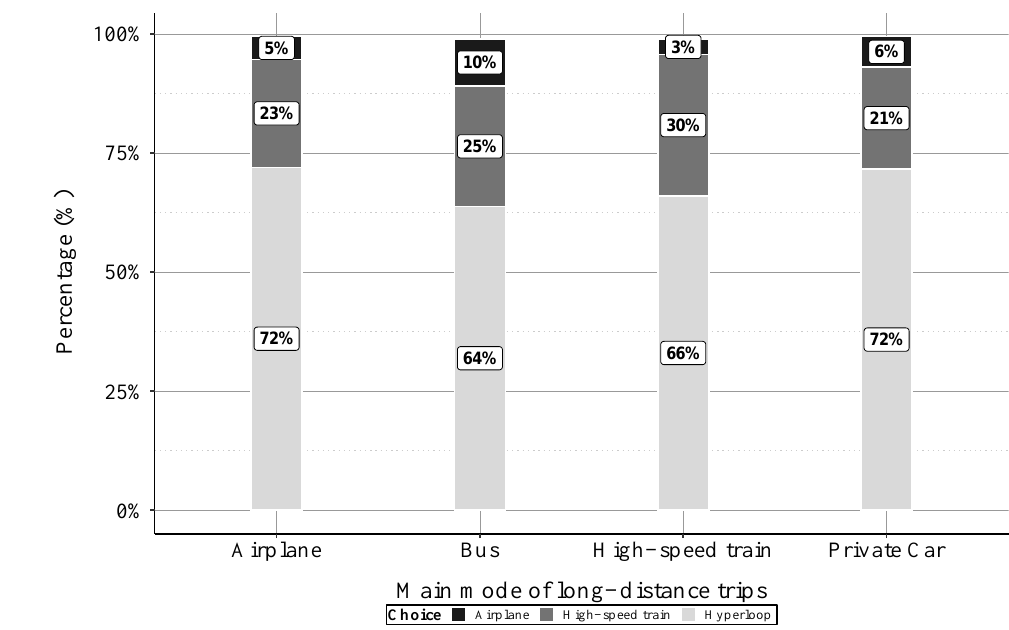
Figure 7. Relationship between the mode for long-distance trips and mode chosen in the experiment excluding the “None”